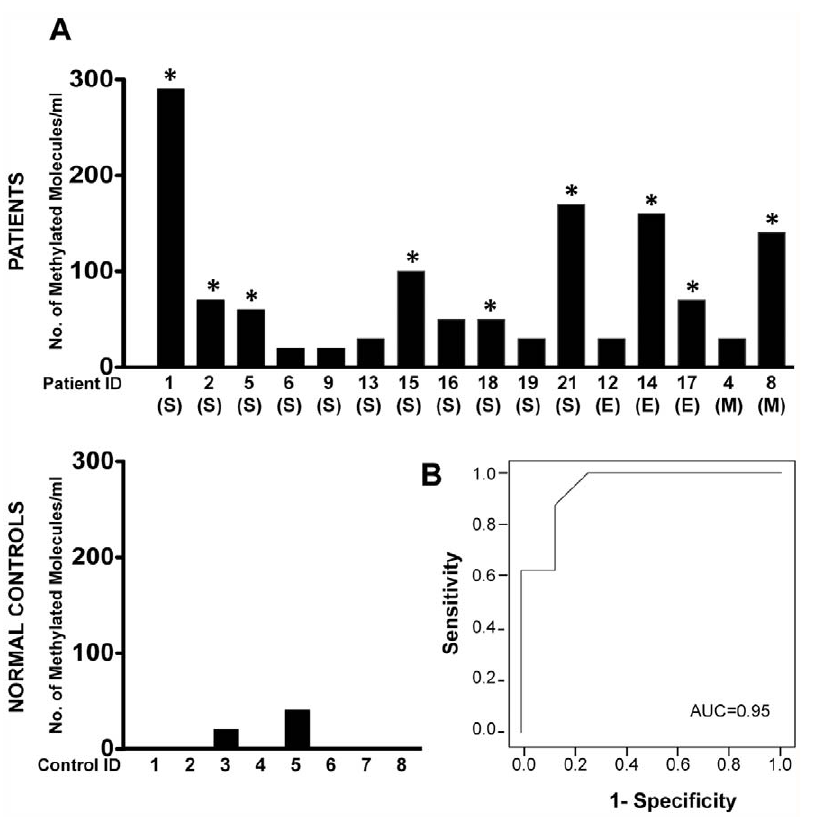
Figure 5. The performance of IFFO1-M marker in the baseline serum samples of ovarian cancer patients and disease-free control women. A, IFFO1-M levels (expressed as the number of IFFO1-M methylated molecules detected in 1 ml sera) in the baseline samples of 16 patients and eight normal controls were determined by Digital MethyLight. The number of molecules in patient # 1 is an approximation since counts higher than 15 hits/96-well plate/100 m l tested could reflect the presence of more than one molecule/well. The histological subtype of the tumors is indicated in parenthesis as follows: serous (S), mucinous (M), and endometrioid (E). The asterisks indicate the patient from whom samples were used in the subsequent longitudinal analysis. B, Receiver operating characteristic curve for IFFO1-M. AUC=area under the